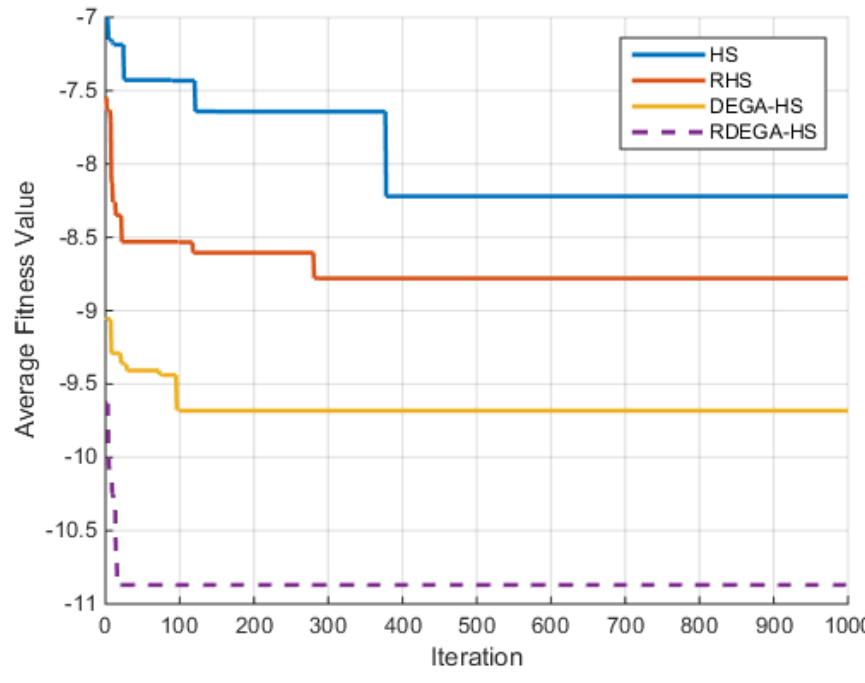
Figure 5. Change in average optimal fitness value of Griewank function with number of iterations. Table 5. Results of the Griewank function under different optimization